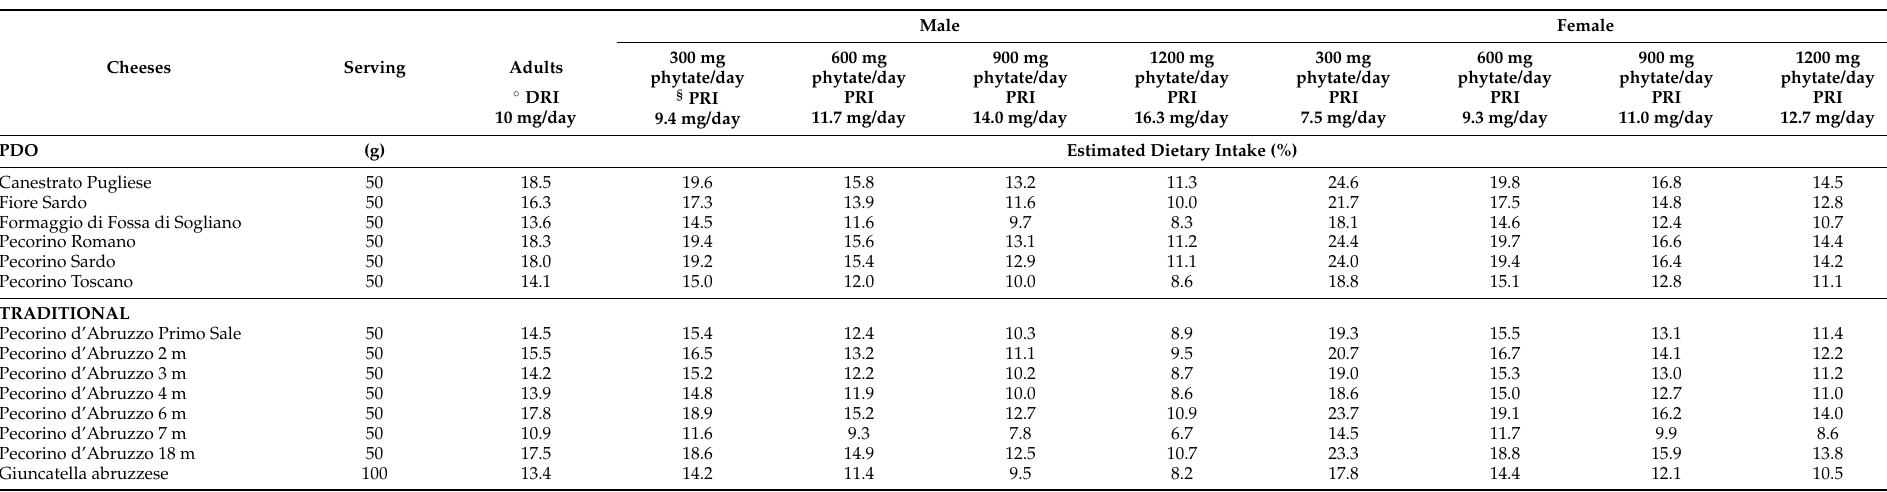
Table 5. Estimated Dietary Intake (%) of zinc in adults calculated according to the reference values of EU [28] and EFSA [13], with a serving (50 g or 100 g) of cheese from sheep milk. Male Female Cheeses